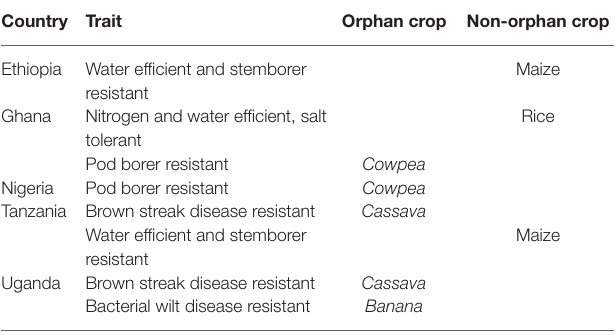
Maize Rice Maize